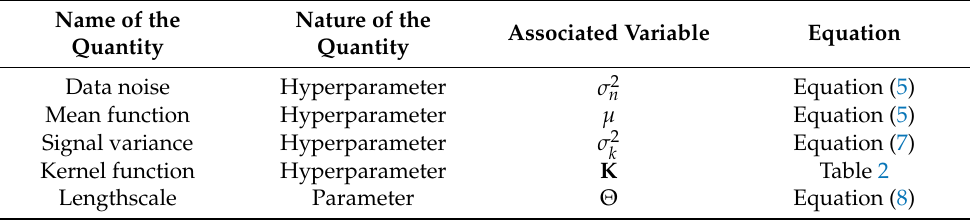
Table 3. GP parameter and